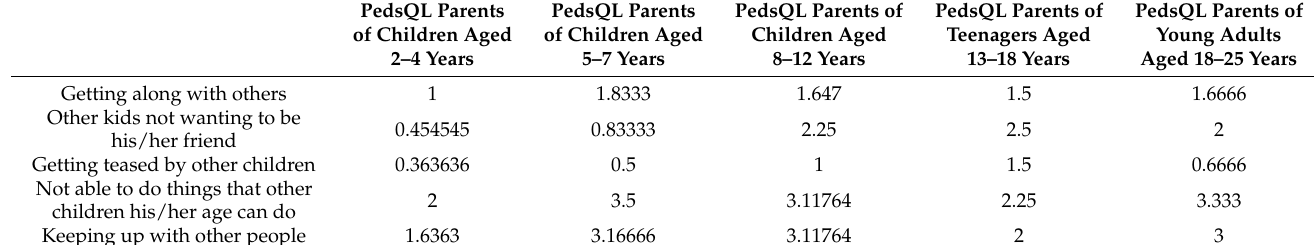
Table 7. Social functioning of DS patients.